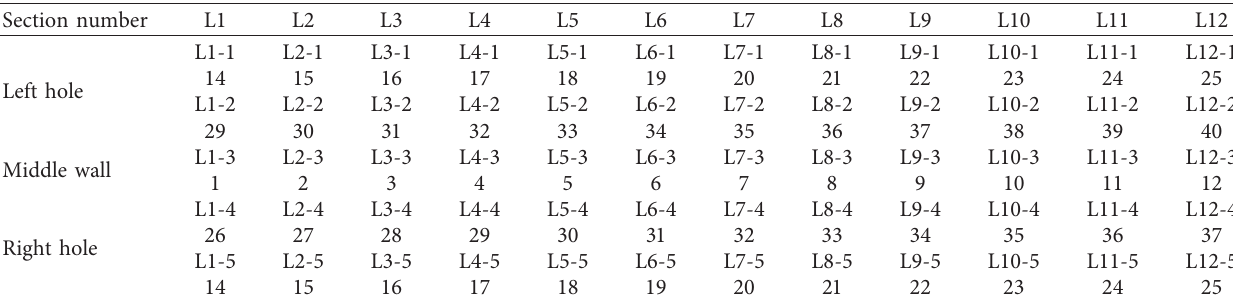
Table 3: Excavation sequence of excavation scheme II.